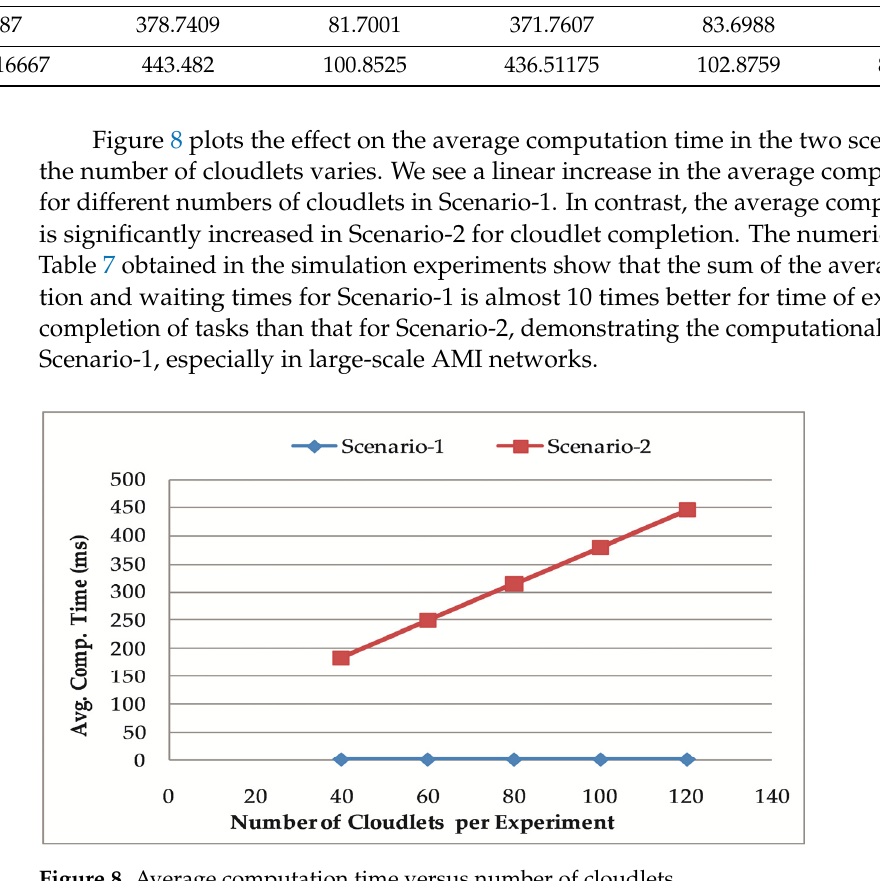
Figure 8. Average computation time versus number of cloudlets.